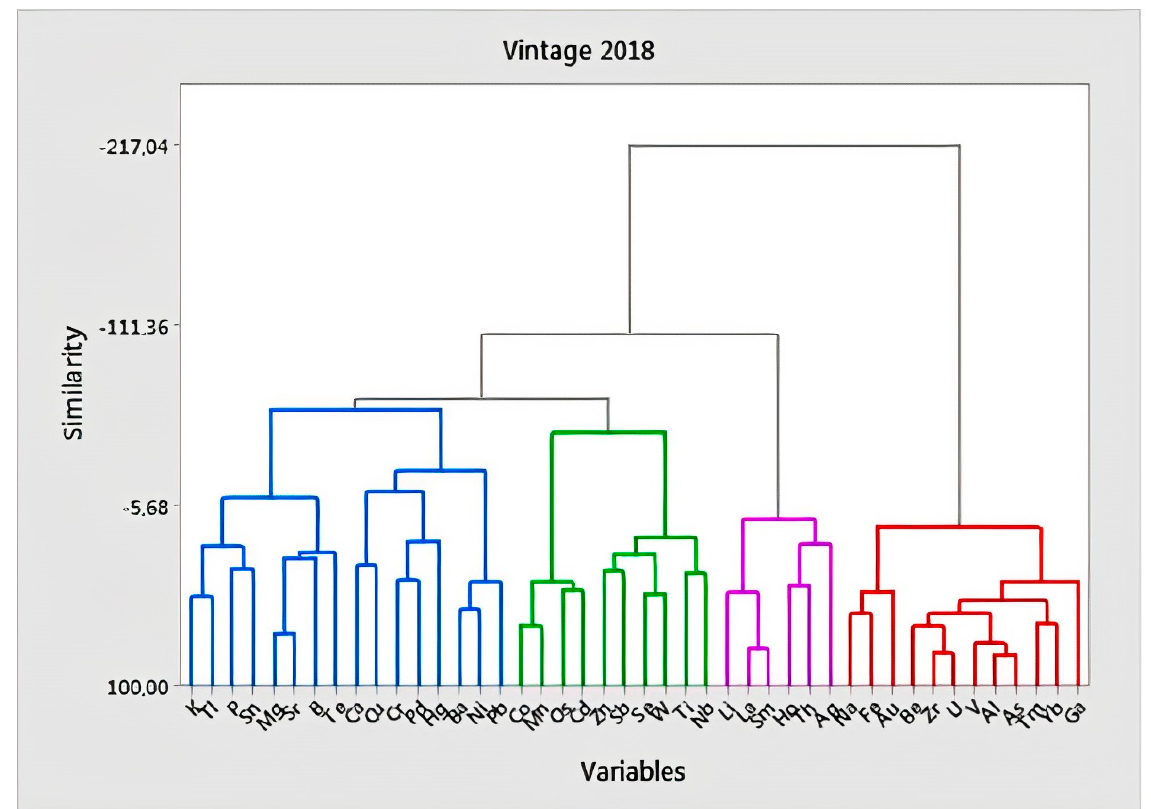
Figure 2. Hierarchical dendrogram for 44 chemical variables for the vintage year 2018. The clustering led to the following 4 significant clusters: K1 (K, Tl, P, Sn, Mg, Sr, B, Te, Ca, Cu, Cr, Pd, Hg, Ba, Ni, Pb), K2 (Co, Mn, Os, Cd, Zn, Sb, Se, W, Ti, Nb), K3 (Li, La, Sm, Ho, Th, Ag), and K4 (Na, Fe, Au, Be, Zr, U, V, Al, As, Tm, Yb, Ga).